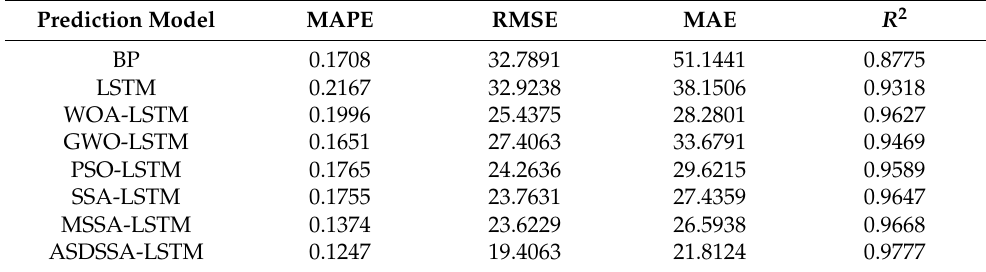
Table 10. Error evaluation of different